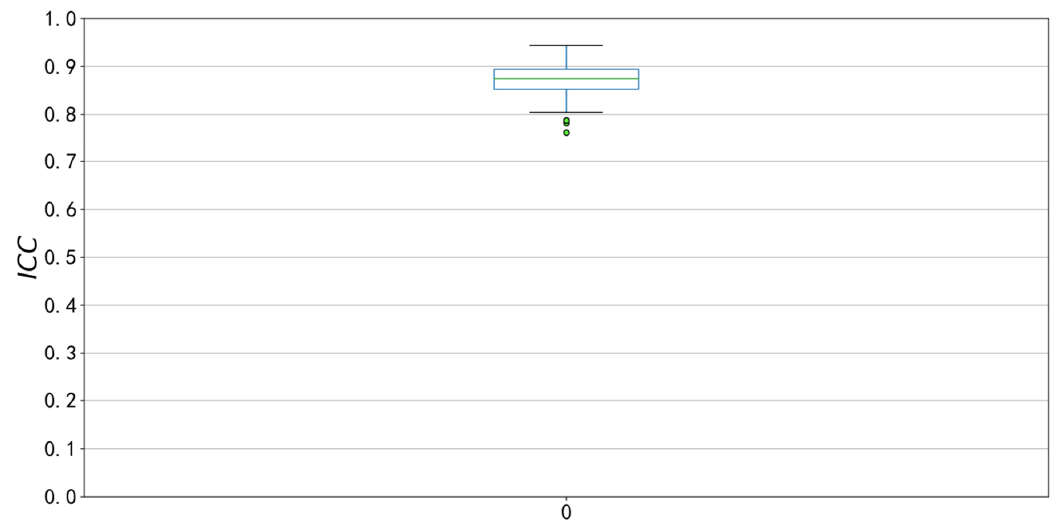
Figure 6. Box plot of ICC of general vehicles.